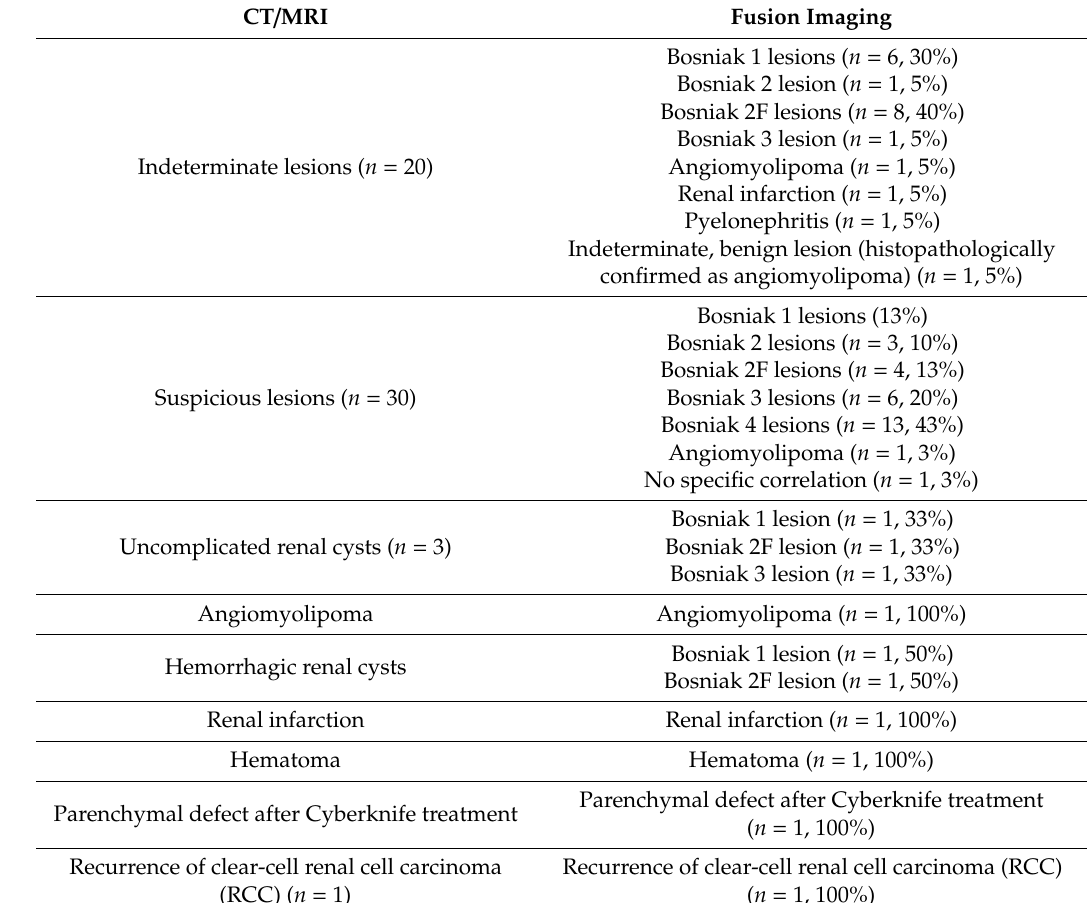
Table 2. Overview of findings from cross-sectional imaging (CT / MRI) and corresponding correlates by fusion imaging in 60 patients with focal renal lesions, CT- computed tomography, MRI-magnetic resonance